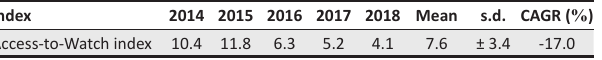
TABLE 2: Access-to-Watch index.